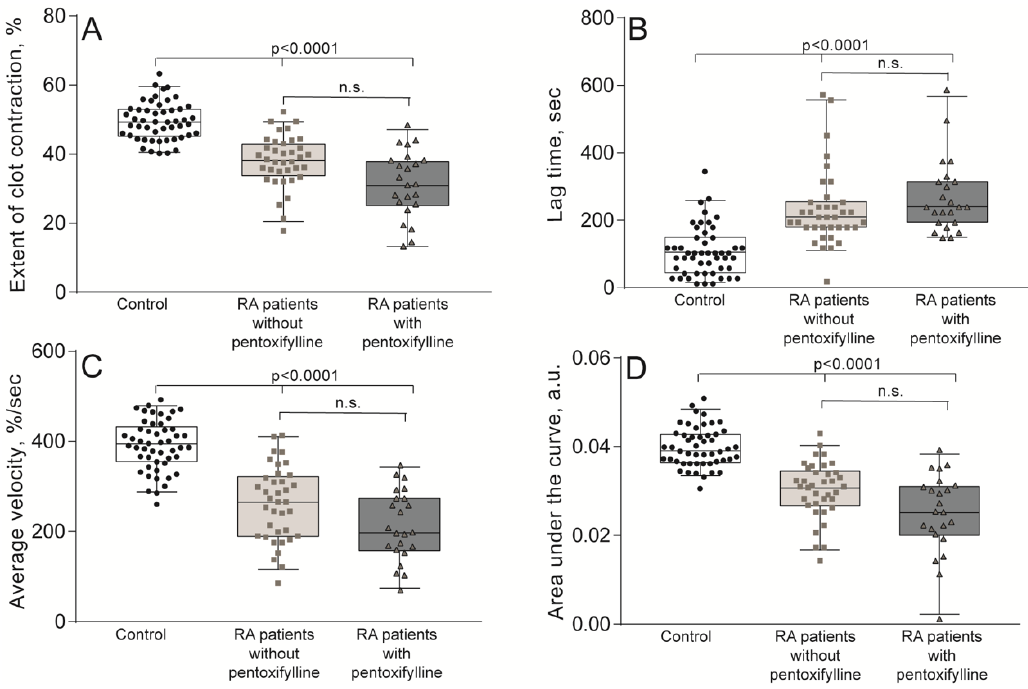
Figure 5. Quantification of contraction of blood clots in patients with RA, not taking ( n = 37) and taking ( n = 23) pentoxifylline, compared with the control group ( n = 50). The extent of clot contraction ( A ), lag time of contraction ( B ), average velocity of contraction ( C ), and area under the curve (work performed by platelets in contraction) ( D ). The results are presented as the median and intervals between 25th and 75th, as well as between 5th and 95th percentiles (Kruskal-Wallis test and Dunn’s multiple post-hoc test). n.s.—not significant.